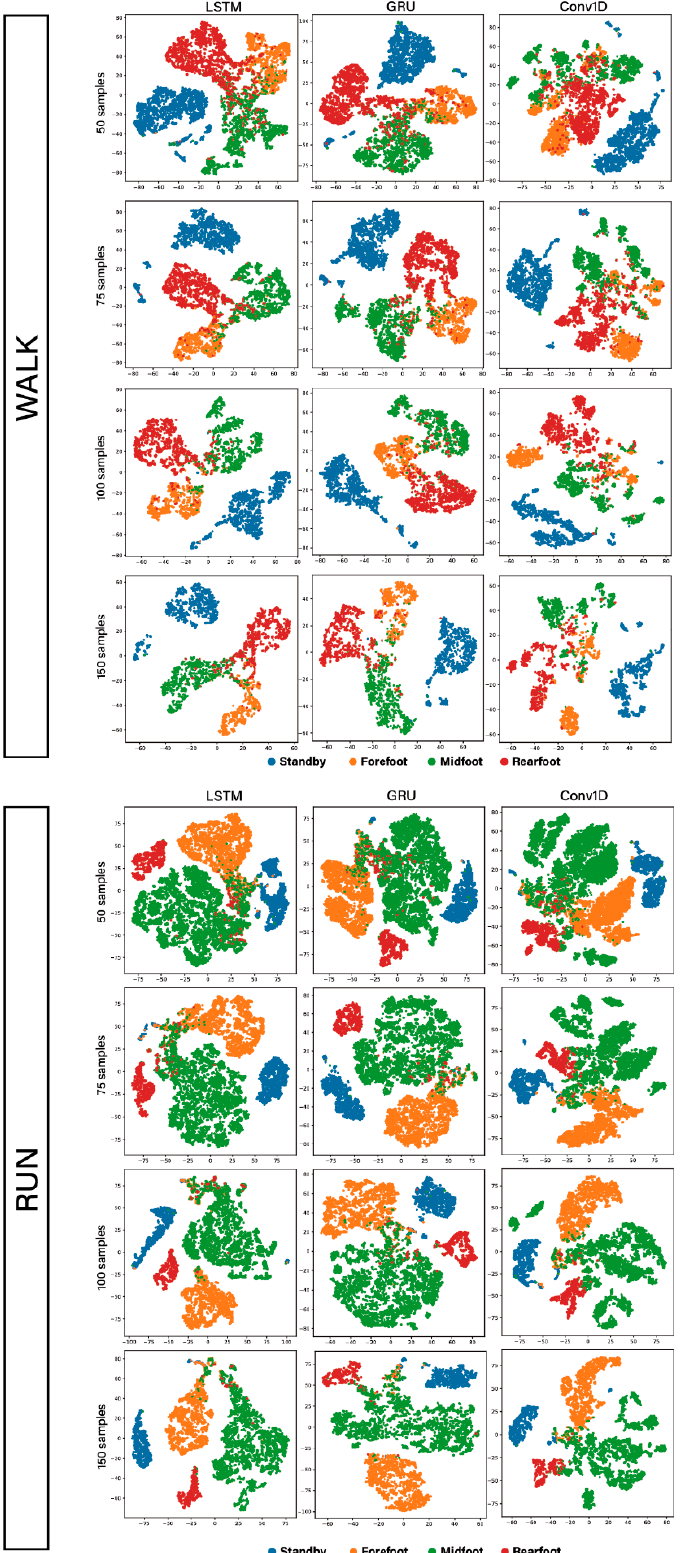
Figure A2. Visualization of internal features using t-SNE (employing all the test data from the walking and running condition). As a nonlinear dimensionality reduction technique, t-SNE was applied in Figure A2. Each 2D point represents the projected feature embedding of a data segment of approximately 1